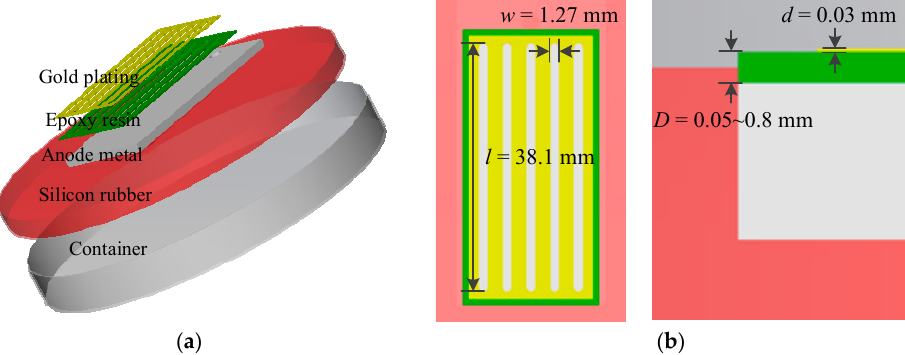
Figure 2. Component of a galvanic cell sensor ( a ) and its structure parameters ( b ).